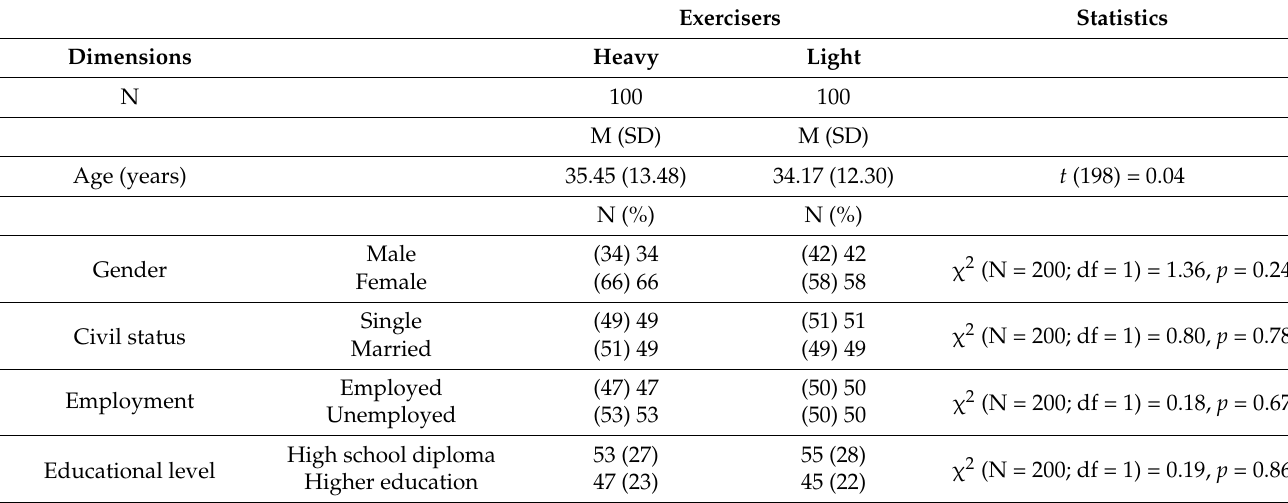
Table 1. Overview of sociodemographic information on heavy and light